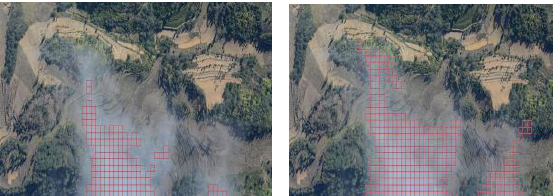
Figure 7. The images of different methods